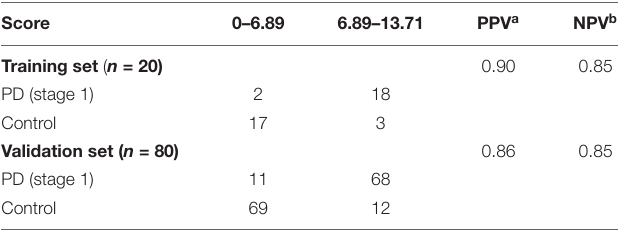
TABLE 2 | Risk score analysis of in PD and cancer-free control plasma samples.